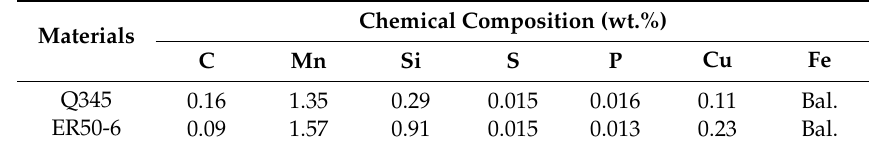
Table 1. The chemical composition of the base metal and welding wire.